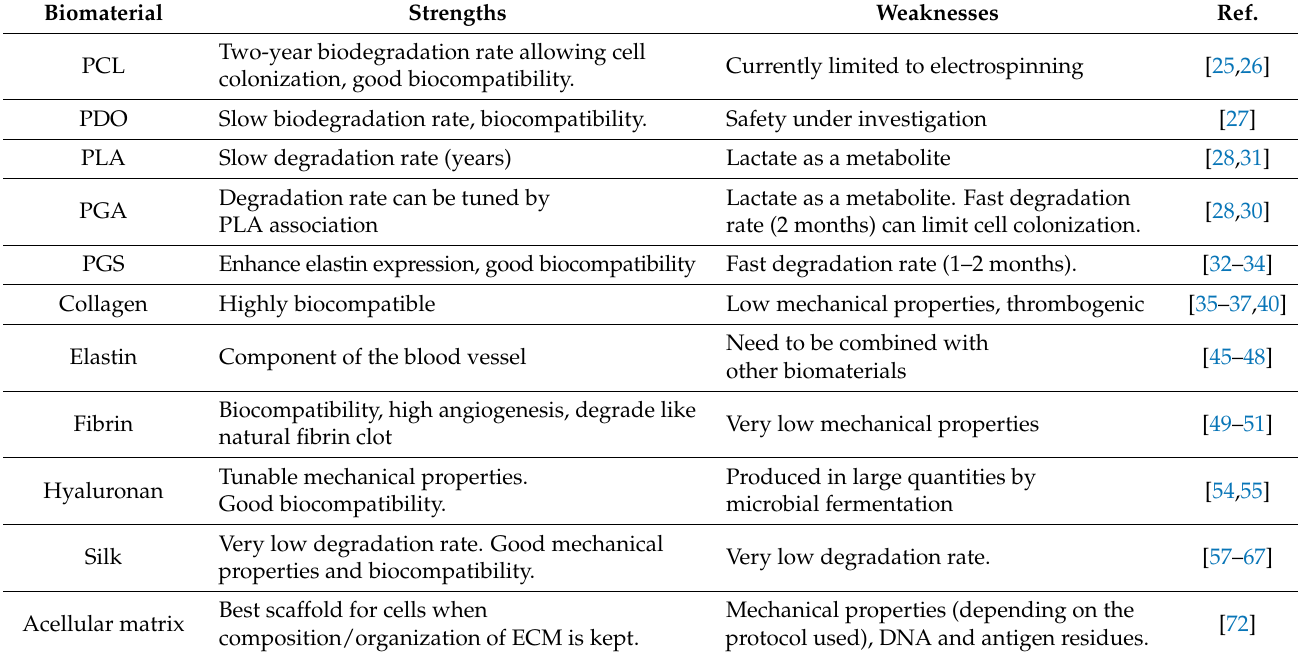
Table 1. Strengths and weaknesses of the biomaterials used in vascular